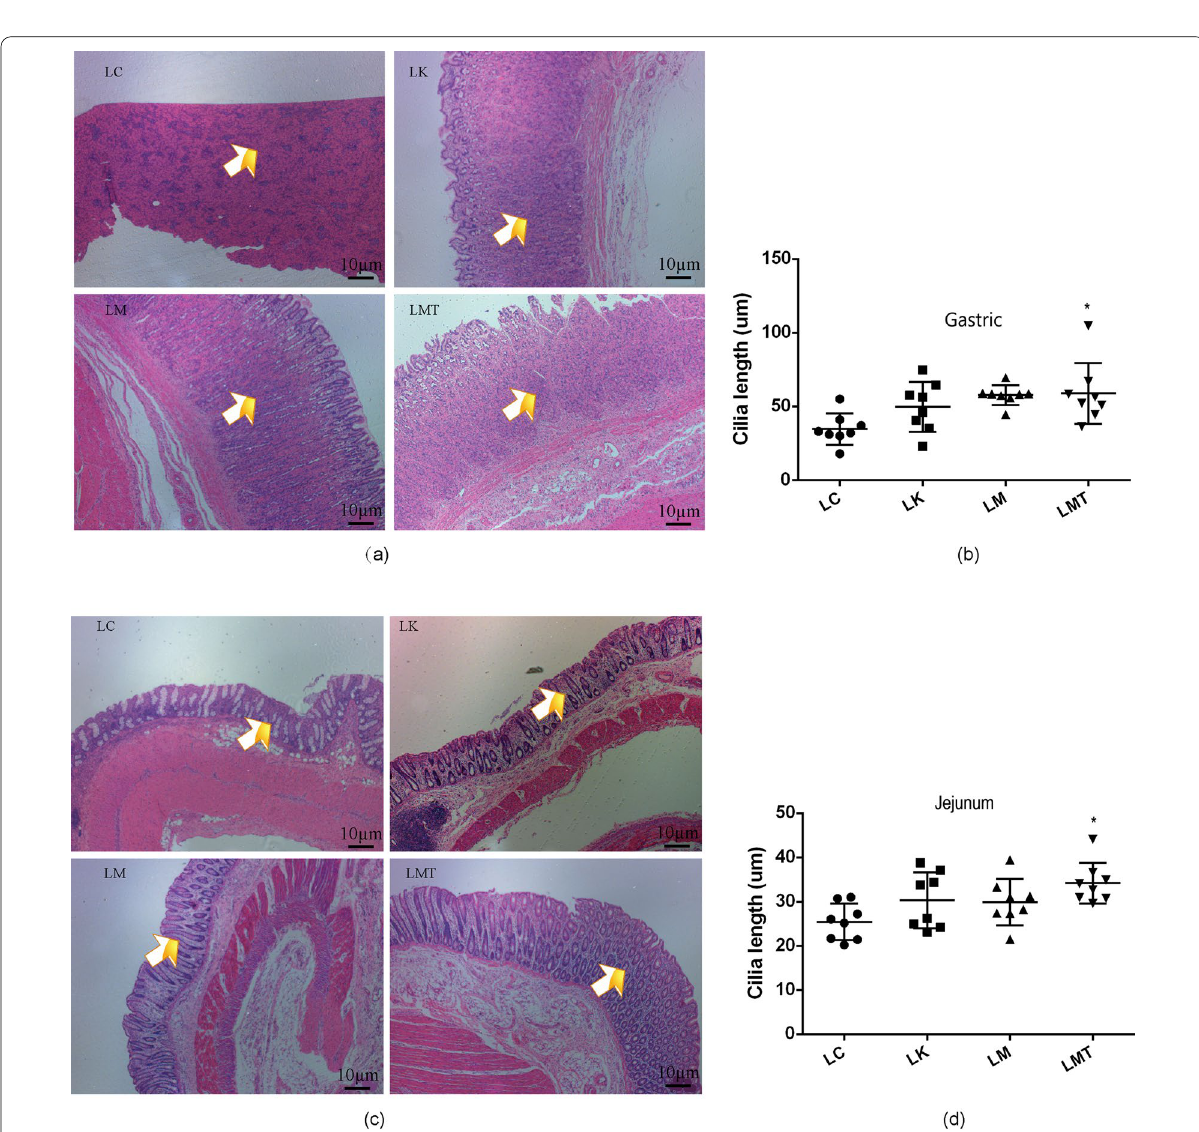
Fig. 3 Morphological changes in gastrointestinal villi of the weaned piglets. a Morphological changes of gastric villi in the weaned piglets. b The length of gastric villi. c Morphological changes in the jejunum of the weaned piglets. d The lengths of jejunal villi in different groups (* p < 0.05; **p < 0.02; ***p < 0.01